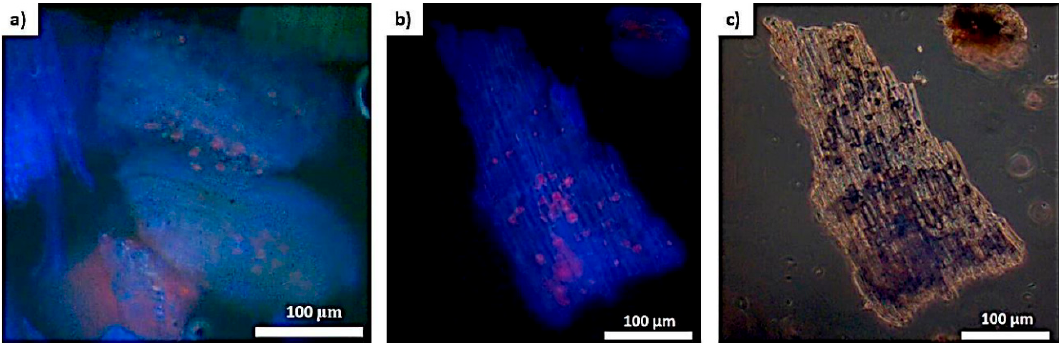
Figure 4. Milled RH (fragments with average size of 200–400 µm): ( a , b ) Fluorescence microscopy, ( c ) phase contrast image.